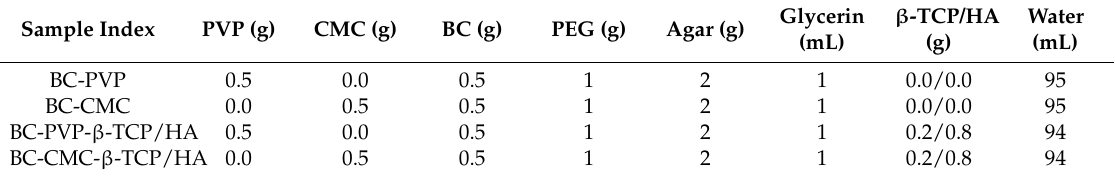
Table 1. Composition of inorganic calcium phosphate filled BC based hydrogel scaffold